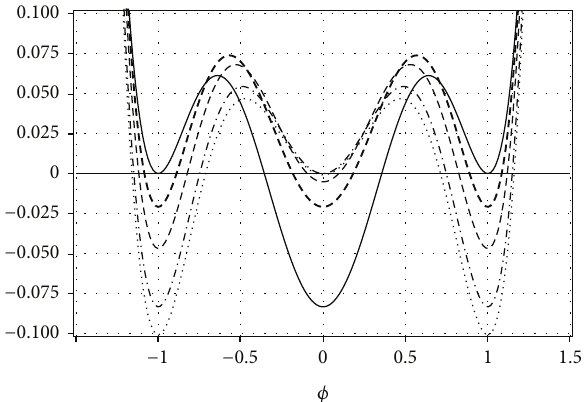
Figure 4: The potential given by (16) for 𝑐 = −1/2 (solid line), 𝑐 = −1/4 (long dashed line), 𝑐 = −1/8 (dashed line), 𝑐 = 0 (dot-dashed line), and 𝑐 = 1/20 (dotted line).